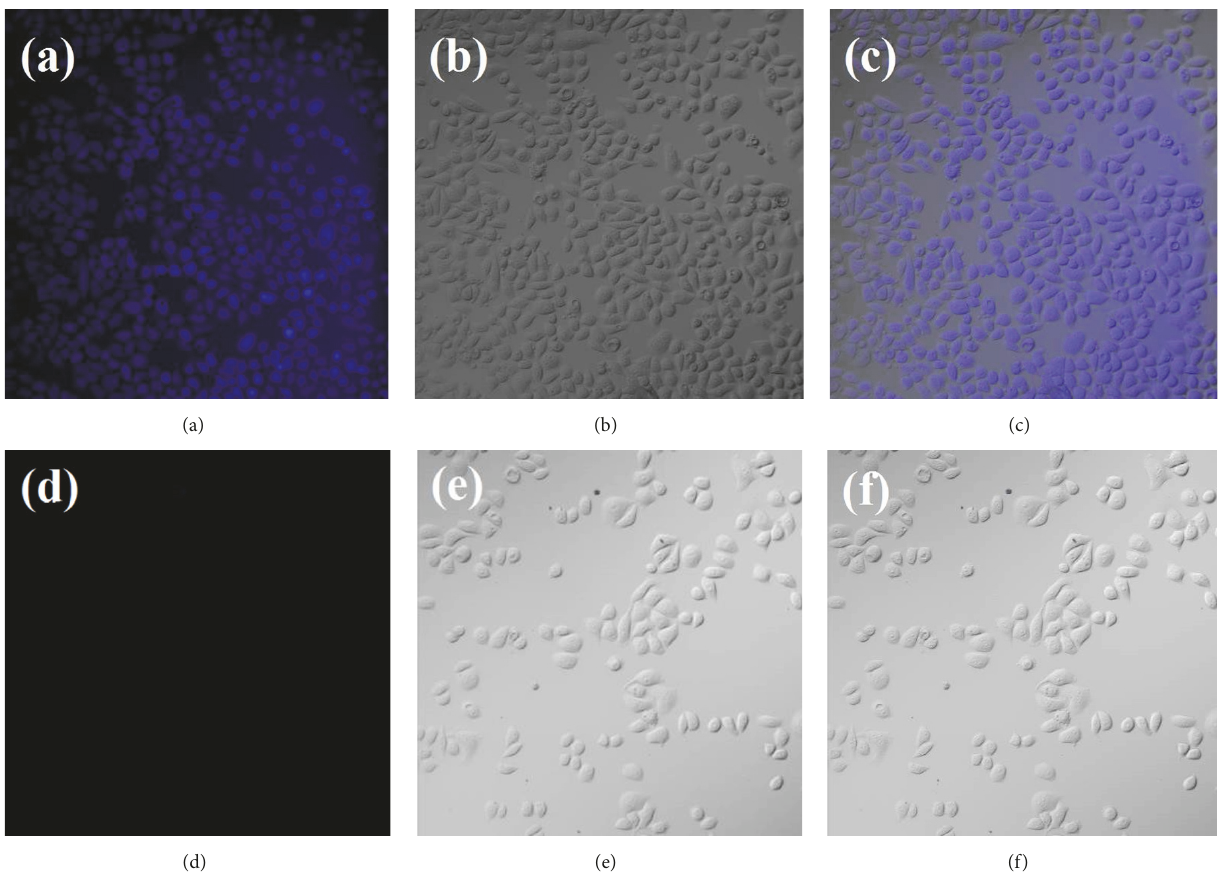
Figure 9: Confocal laser scanning microscopy images of living Eca9706 cells. (a) Fluorescence image of Eca9706 cells incubated with 0.15 mg/ml DDQ for 40 min at 37 ∘ C. (b) Bright-field transmission image of Eca9706 cells shown in panel (1). (c) Overlay image of (a) and (b). (d) Fluorescence image of Eca9706 cells pretreated with 1mM N-methylmaleimide (a masking reagent for thiols) at 37 ∘ C for 30 min and then cultured with 0.15 mg/ml DDQ for 40 min at 37 ∘ C. (e) Bright-field transmission image of Eca9706 cells shown in panel (d). (f) Overlay image of (d) and